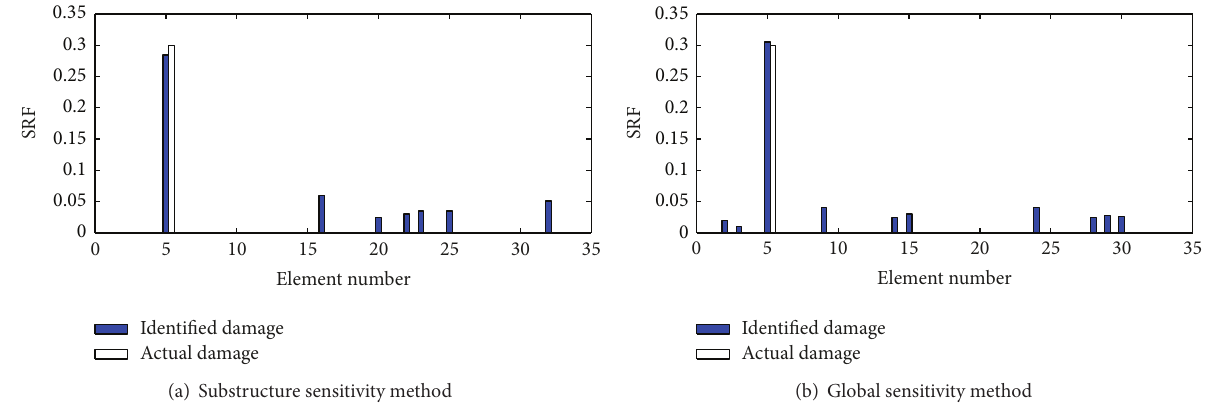
Figure 5: Damage detection results (Case 4).